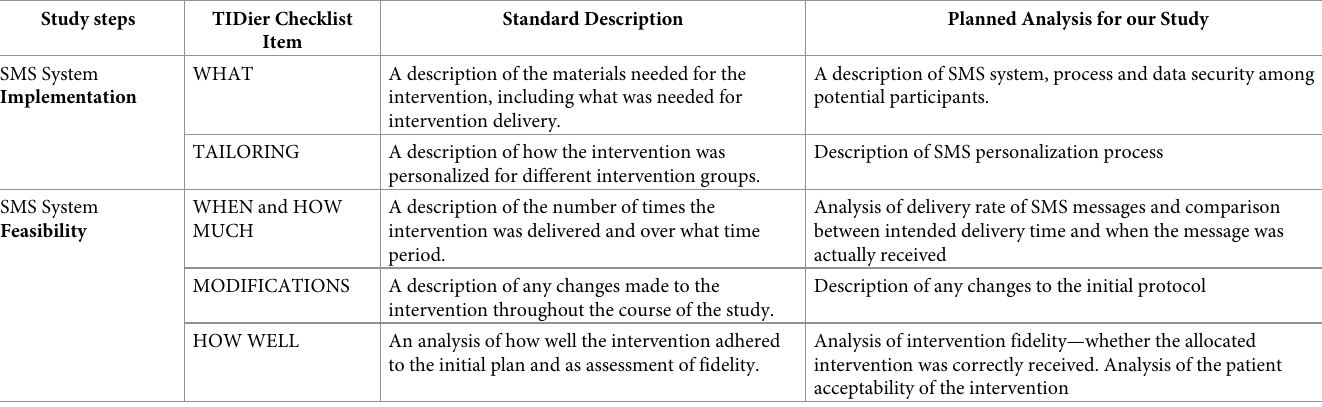
Table 1. Adapted TIDier checklist used to assess intervention